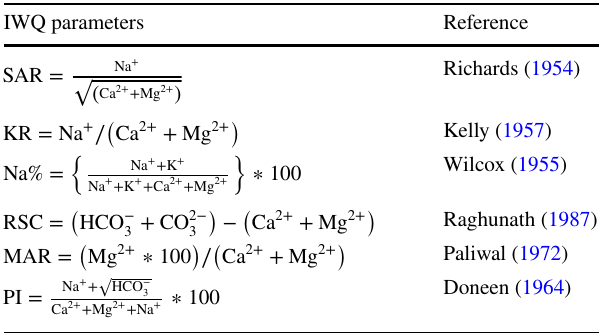
Table 2 Equation used to estimate the suitability for irrigation water quality (IWQ)